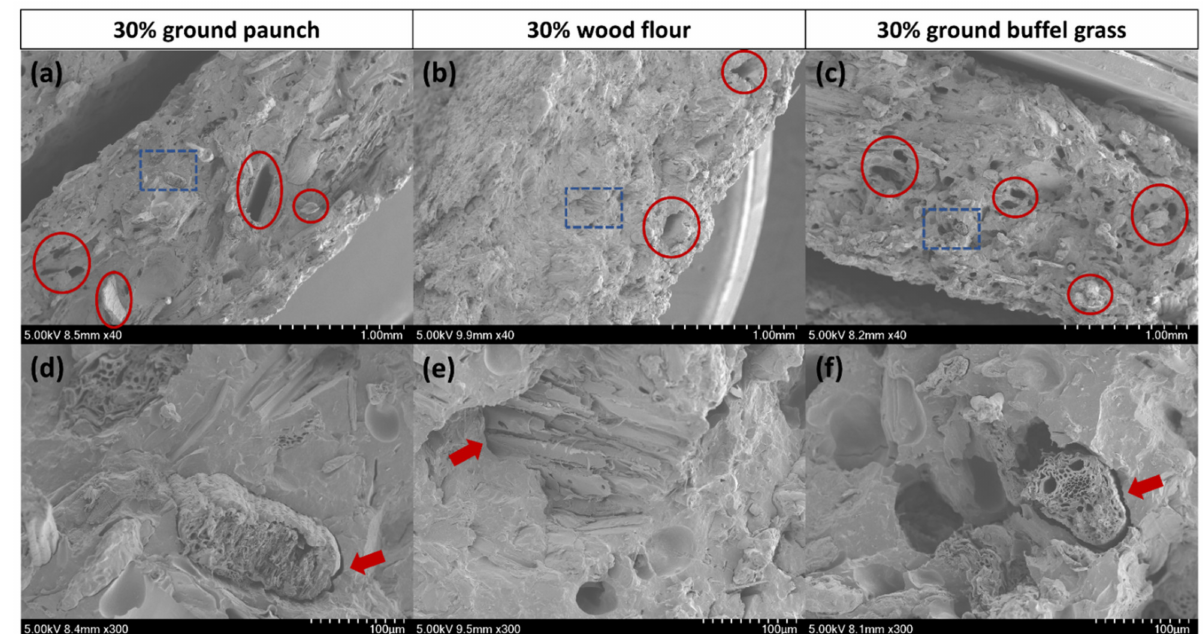
Figure 8. SEM micrographs of the fractured surface of ( a , d ) PHBV/ground paunch, ( b , e ) PHBV/wood flour and ( c , f ) PHBV/ground buffel grass composites at a fibre content of 30 wt%. The magnified regions are indicated by blue-dashed boxes. Key features are annotated by red circles for fibre pull-outs and red arrows for interface regions.